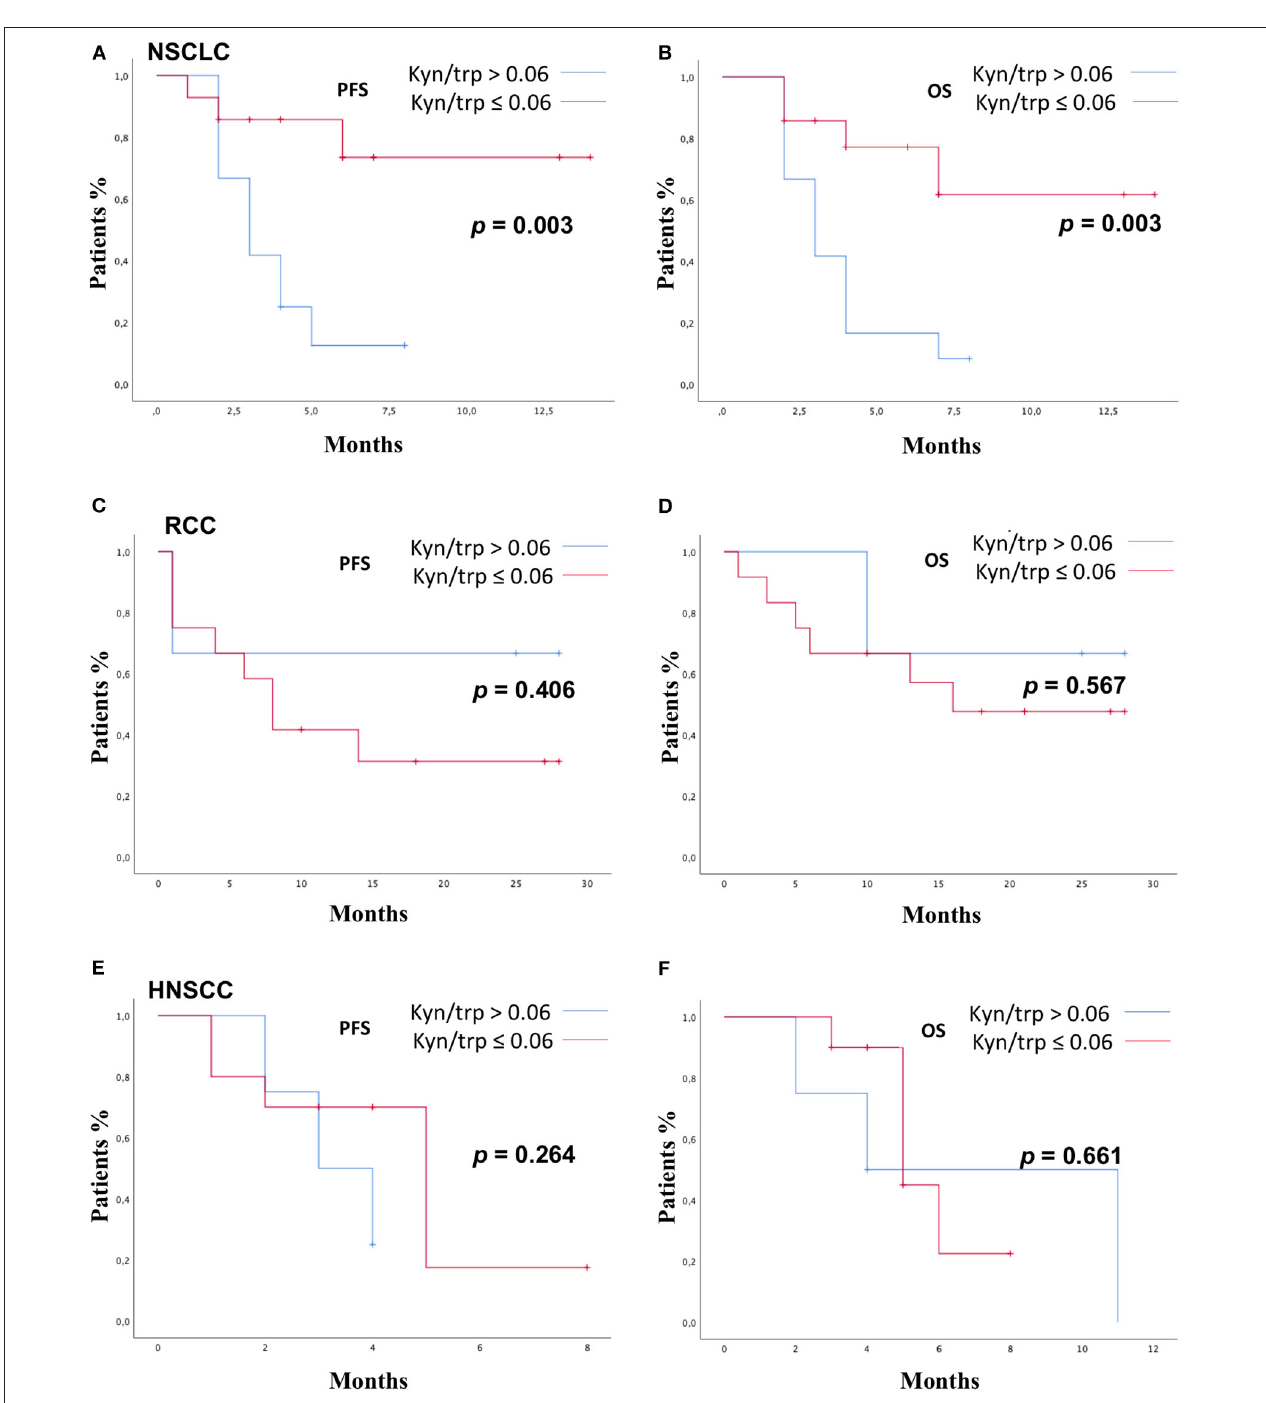
FIGURE 4 | PFS and OS according to kyn/trp in NSCLC group (A,B) , RCC group (C,D) , and HNSCC group (E,F) were addressed by the Kaplan–Meier method and log-rank test. PFS, progression-free survival; OS, overall survival; kyn, kynurenine; trp, tryptophan; NSCLC, non-small cell lung cancer; RCC, renal cell carcinoma; HNSCC, head and neck squamous cell